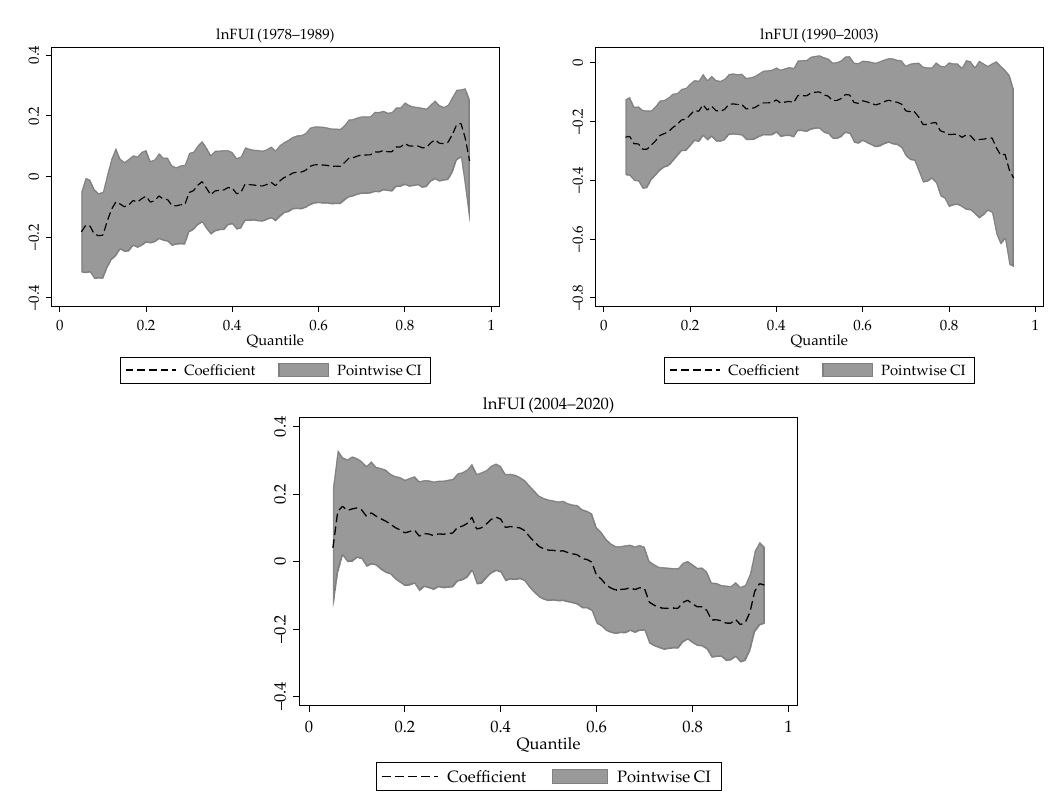
Figure A2. Variation of FUI coefficients in sub-periods at different quartiles.